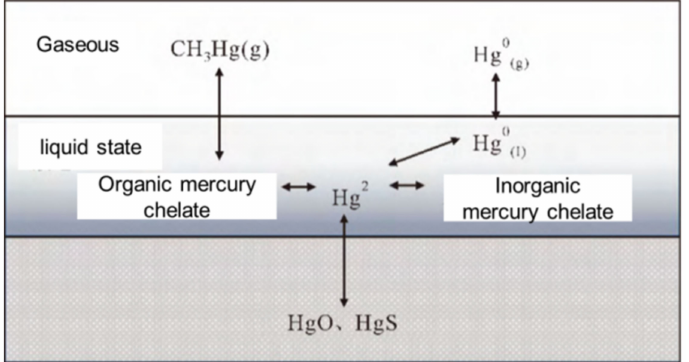
Figure 1. Mercury transformations in landfill